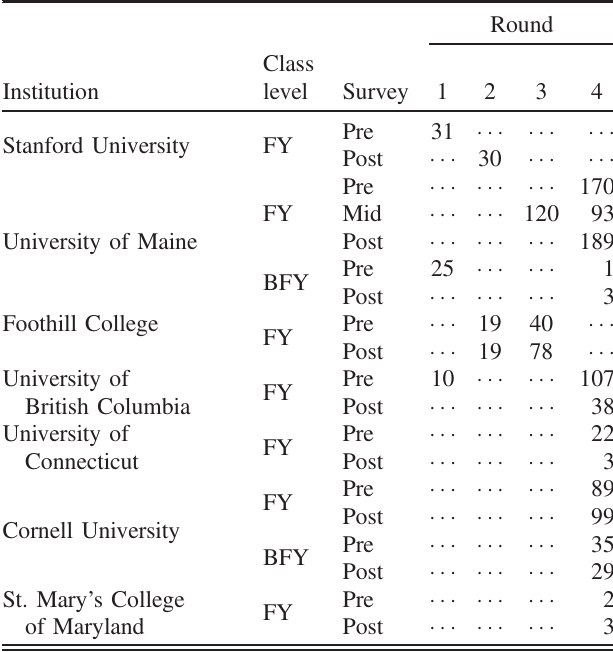
TABLE III. Summary of the number of open-response PLIC surveys that were analyzed for early construct validity tests and to develop the closed-response format. The level of the class (first- year or beyond-first-year) and the point in the semester when the survey was administered are